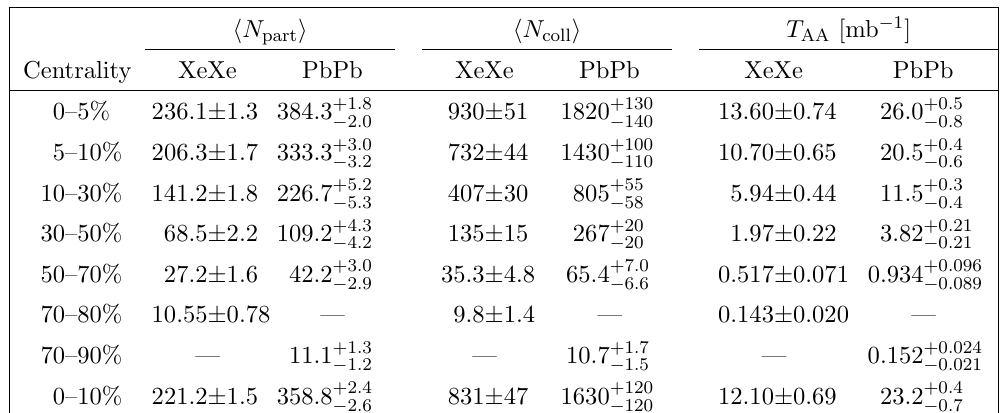
Table 1 . The values of h N part i , h N coll i , T AA , and their uncertainties, for collisions and 5.02 TeV PbPb collisions in the centrality ranges used